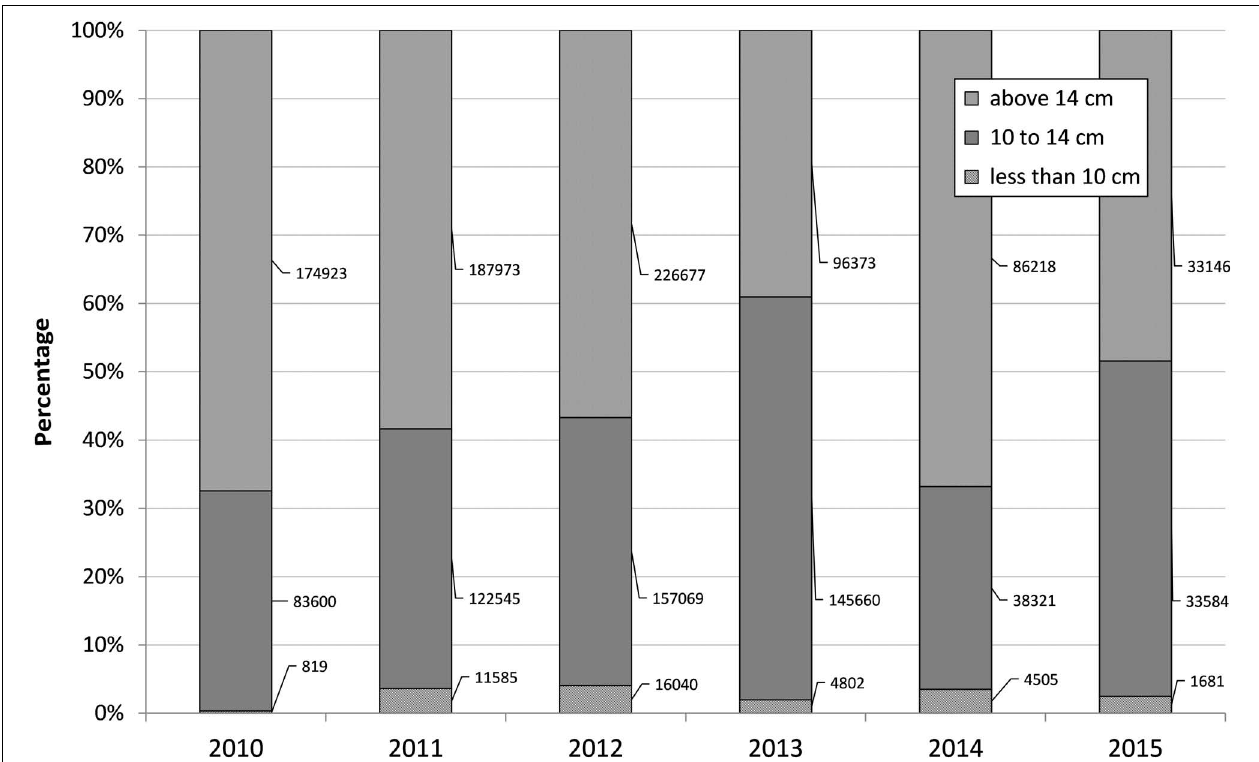
FIGURE 5 | Percent contribution of the three size groups of oil sardine to annual catch during 2010–2015. Figures indicate size group wise tonnage.